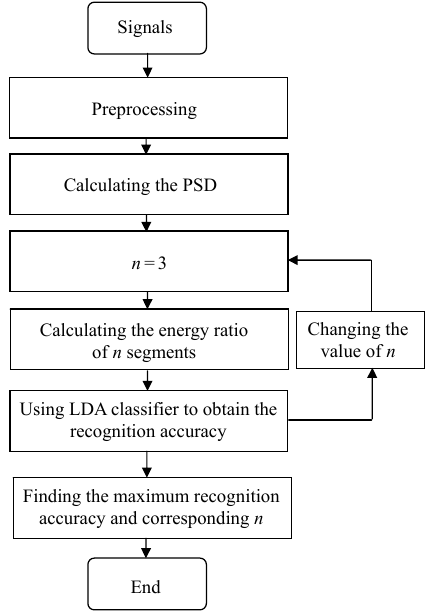
Fig. 1 Processing flow of intrusion signal recognition method of OFPS based on energy